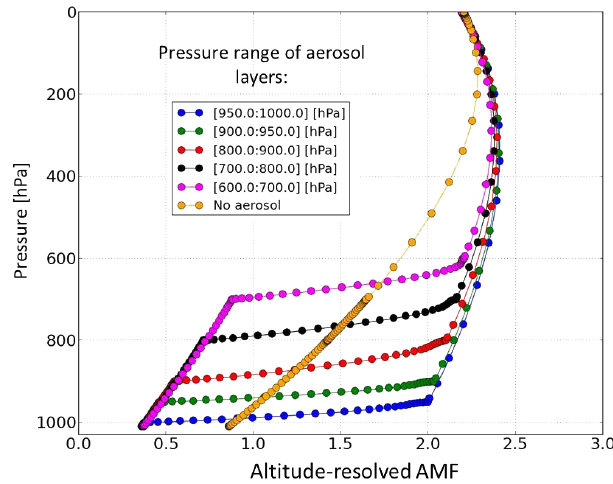
Figure 1. Altitude-resolved AMF at 439nm as computed by DISAMAR for surface albedo = 0.05, SZA = 25 ◦ , VZA = 25 ◦ . Computations are done without and with aerosols at different lay- ers. Aerosols are specified with AOT = 1, SSA = 0.95, Ångström coefficient = 1.5 and asymmetry parameter